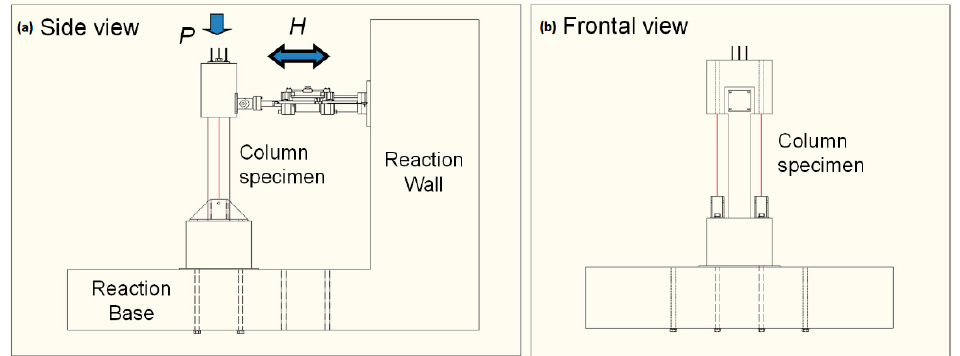
Figure 5. Schematic of column loading test: ( a ) Side view of specimen setup; ( b ) Frontal view of specimen setup.